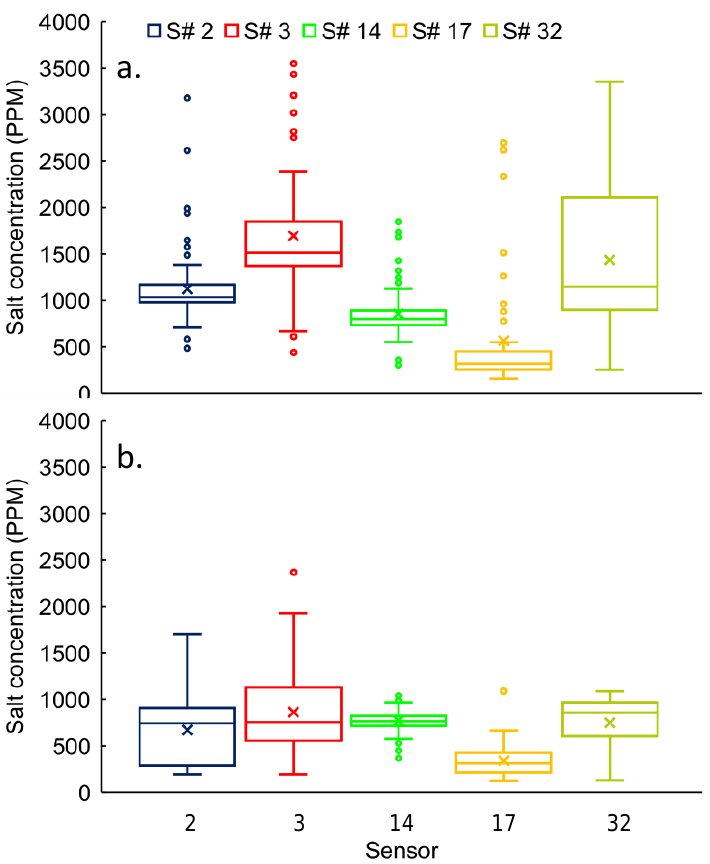
Figure 3. Salt concentrations distribution at parking-lot drains for S# 2, 3, 14, 17, and 32 during ( a ) winter and ( b ) spring seasons. Box plot plotted by Microsoft Excel 2016, represents the lowest, highest, first quartile (25th percentile), median (50th percentile), third quartile (75th percentile) values of errors (%). The sign “X” and “ ○ ” represents the mean and outlier values, respectively. Lower and higher outliers are calculated by equations 25th percentile—1.5 × (75th percentile–25th percentile) and 75th percentile + 1.5 × (75th percentile–25th percentile), respectively.